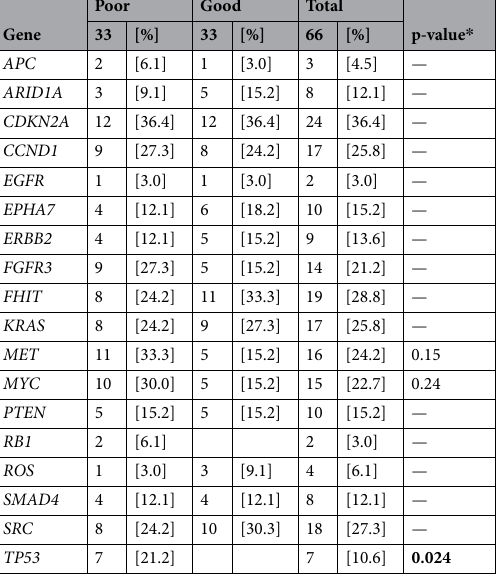
Table 3. Detailed distribution of copy number variations detected in 66 intrahepatic cholangiocarcinomas. Related to Fig. 2. * Fisher test for multiple comparison was used as